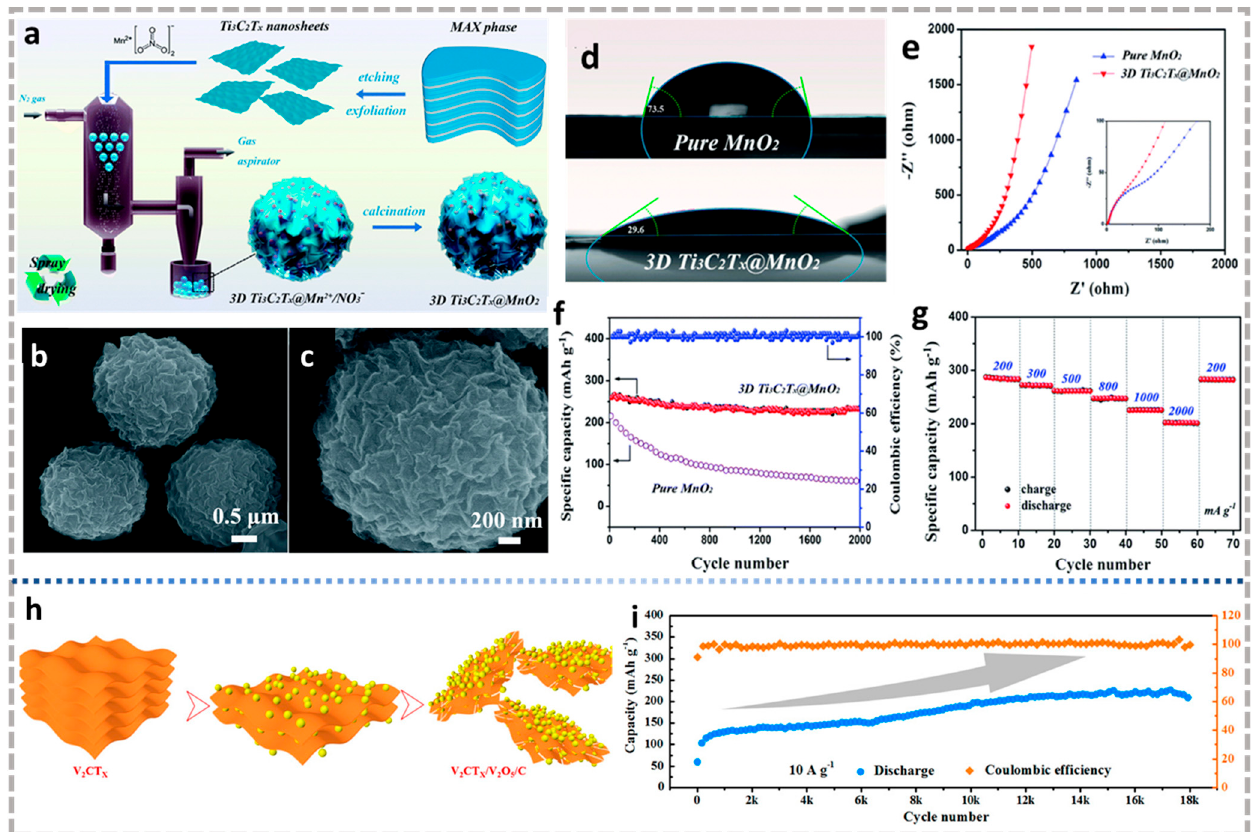
Figure 10. ( a ) Schematic of 3D Ti 3 C 2 T x @MnO 2 micro fl ower synthesis progress. ( b , c ) SEM images of 3D Ti 3 C 2 T x @MnO 2 micro fl owers with di ff erent magni fi cations. ( d ) Contact angles of droplets of electrolyte on the surface of MnO 2 and 3D Ti 3 C 2 T x @MnO 2 micro fl ower. ( e ) Comparison of EIS for MnO 2 and 3D Ti 3 C 2 T x @MnO 2 micro fl ower cathodes in aqueous ZIBs. ( f ) Long-term cycling stability at 500 mA g − 1 ; ( g ) rate performance of 3D Ti 3 C 2 T x @MnO 2 micro fl owers in aqueous ZIBs [100]. ( a – g ) Repro-